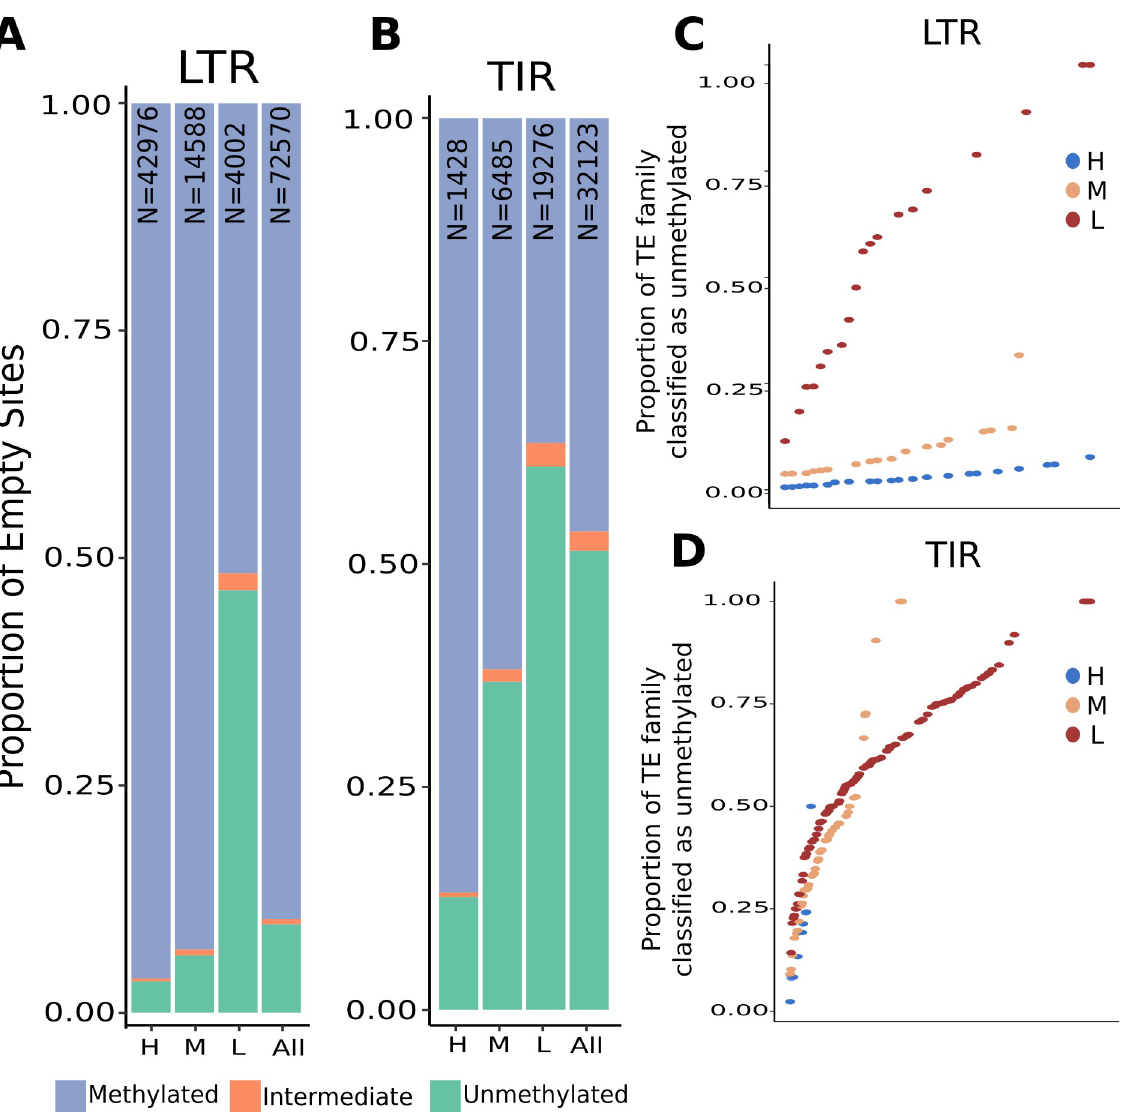
Fig 6. Levels of CG DNA methylation at empty site haplotypes. There are 75,570 LTR (A) and 32,123 TIR (B) TE polymorphisms for which there is WGBS data for the haplotype that lacks the insertion (empty site). The empty sites were classified based on CG methylation level as unmethylated ( < 20%), intermediate (20–40%), or methylated ( > 40%) and the distribution of these three groups is shown for all TEs as well as TEs in families classified as having H, M or L flanking methylation. (C-D) For each TE family with at least 10 empty sites the proportion of CG unmethylated empty sites was determined and used to rank order the